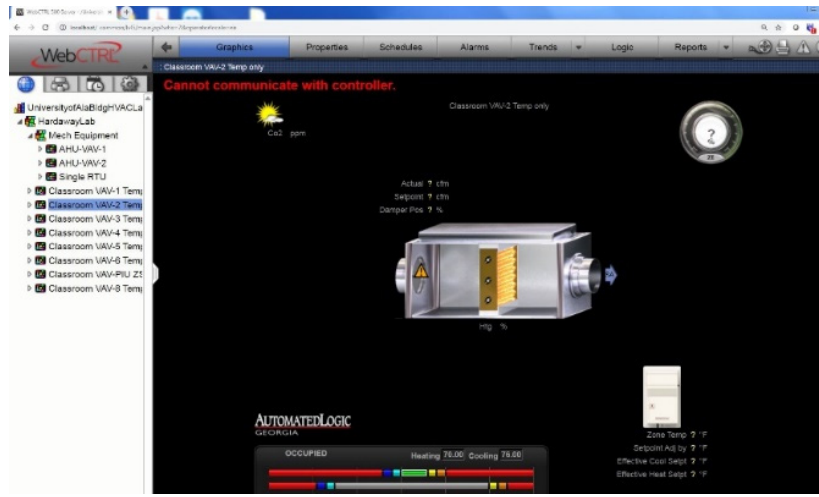
Figure 13. WebCTRL platform.